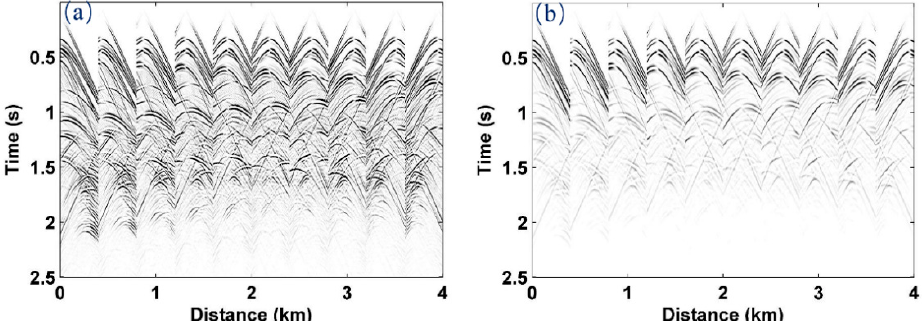
Figure 2. Synthetic shot gathers corresponding to ( a ) the elastic media and ( b ) the loss media. Note that every 4th shot is